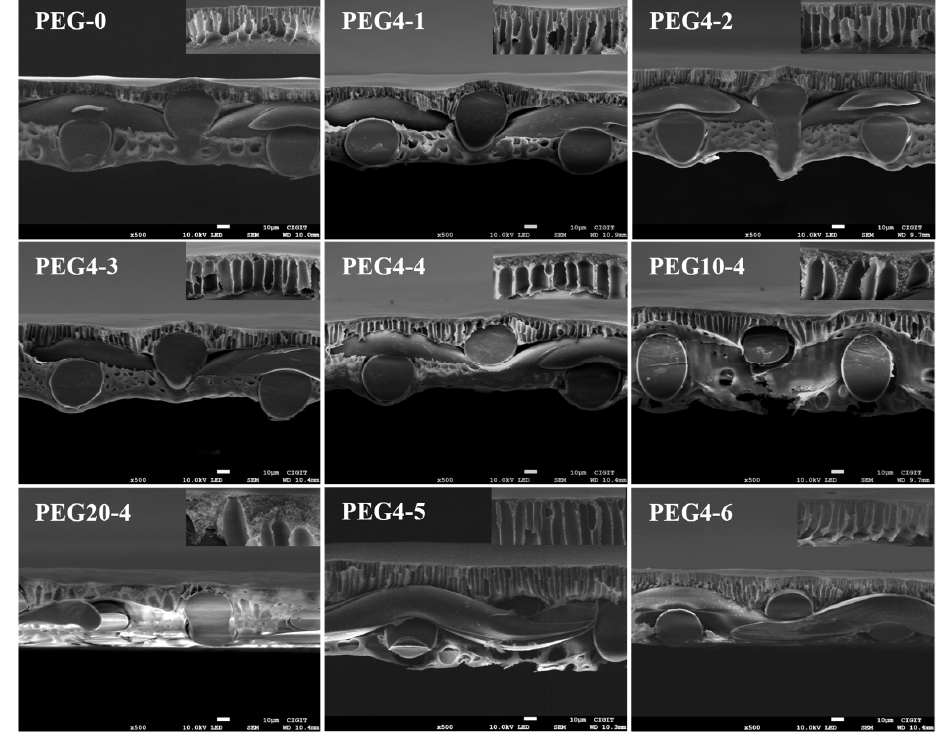
Figure 3. SEM images for the cross-section of PSU and PSU/PEG substrates. The insets reveal the morphologies of the substrates near the top surface at higher